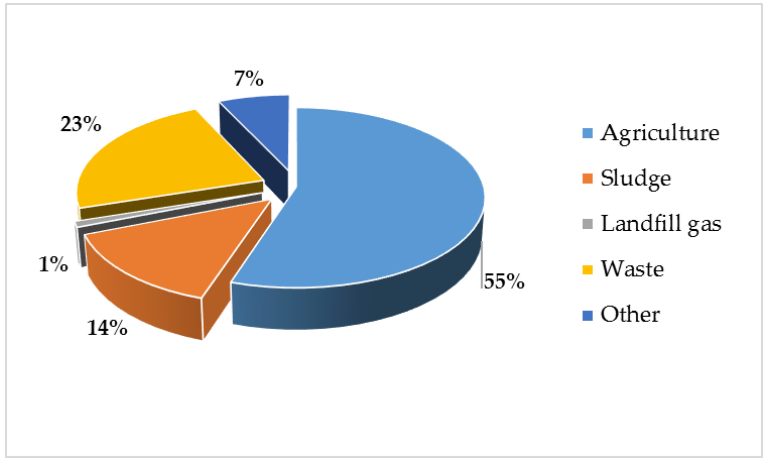
Figure 3. Biomethane plants divided by type of raw materials in Europe (2017).